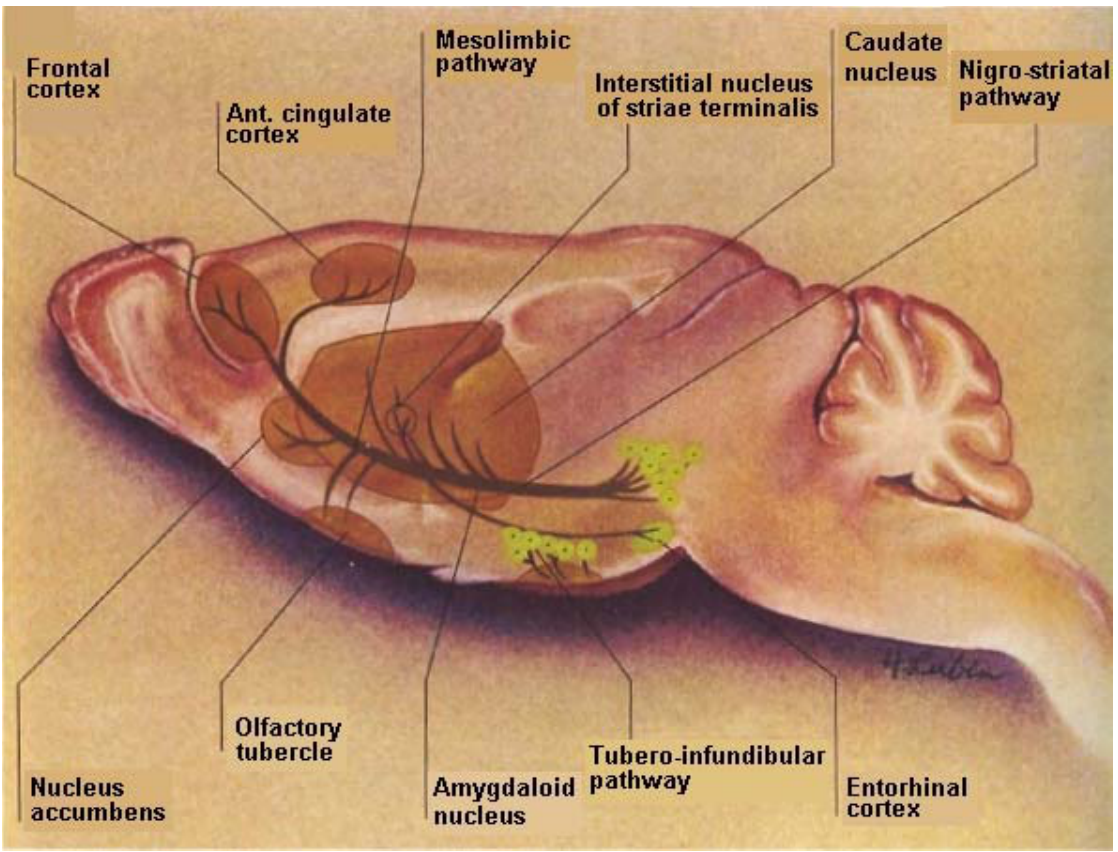
Figure 2. Depicted: Adapted diagram of DA pathways in basal ganglia in rat brain